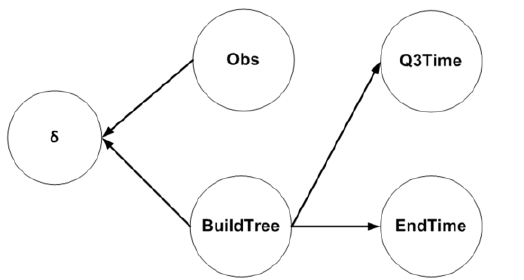
Figure 1. Bayesian network for Build tree